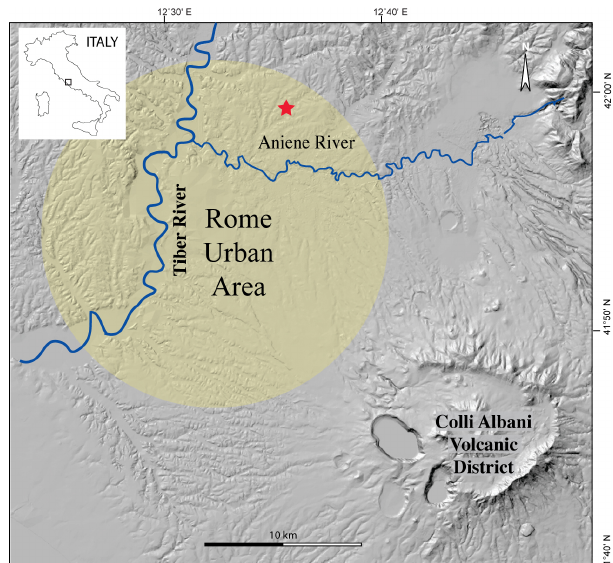
Figure 3. Digital elevation model (DEM) of the Roman area (TINI- TALY by Istituto Nazionale di Geofisica e Vulcanologia (INGV), published with a CC BY 4.0 license; available at: https://doi.org/ 10.13127/TINITALY/1.0), showing the strongly marked character- istics of the river and stream incisions that form the hydrographic network of tributary streams which flow towards (into) the main Tiber and the Aniene rivers. Location of the 11 May 2020 earth- quake is also shown (red